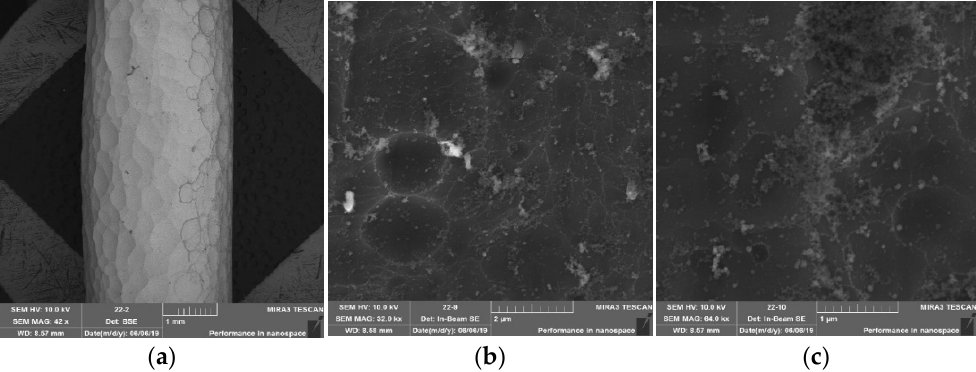
Figure 13. SEM micrographs of the surface of a sample containing five layers of protective coating applied by sequential immersion in tetraethoxysilane and ammonia. ( a ) zoom ×45; ( b ) zoom ×100; ( c ) zoom ×240.